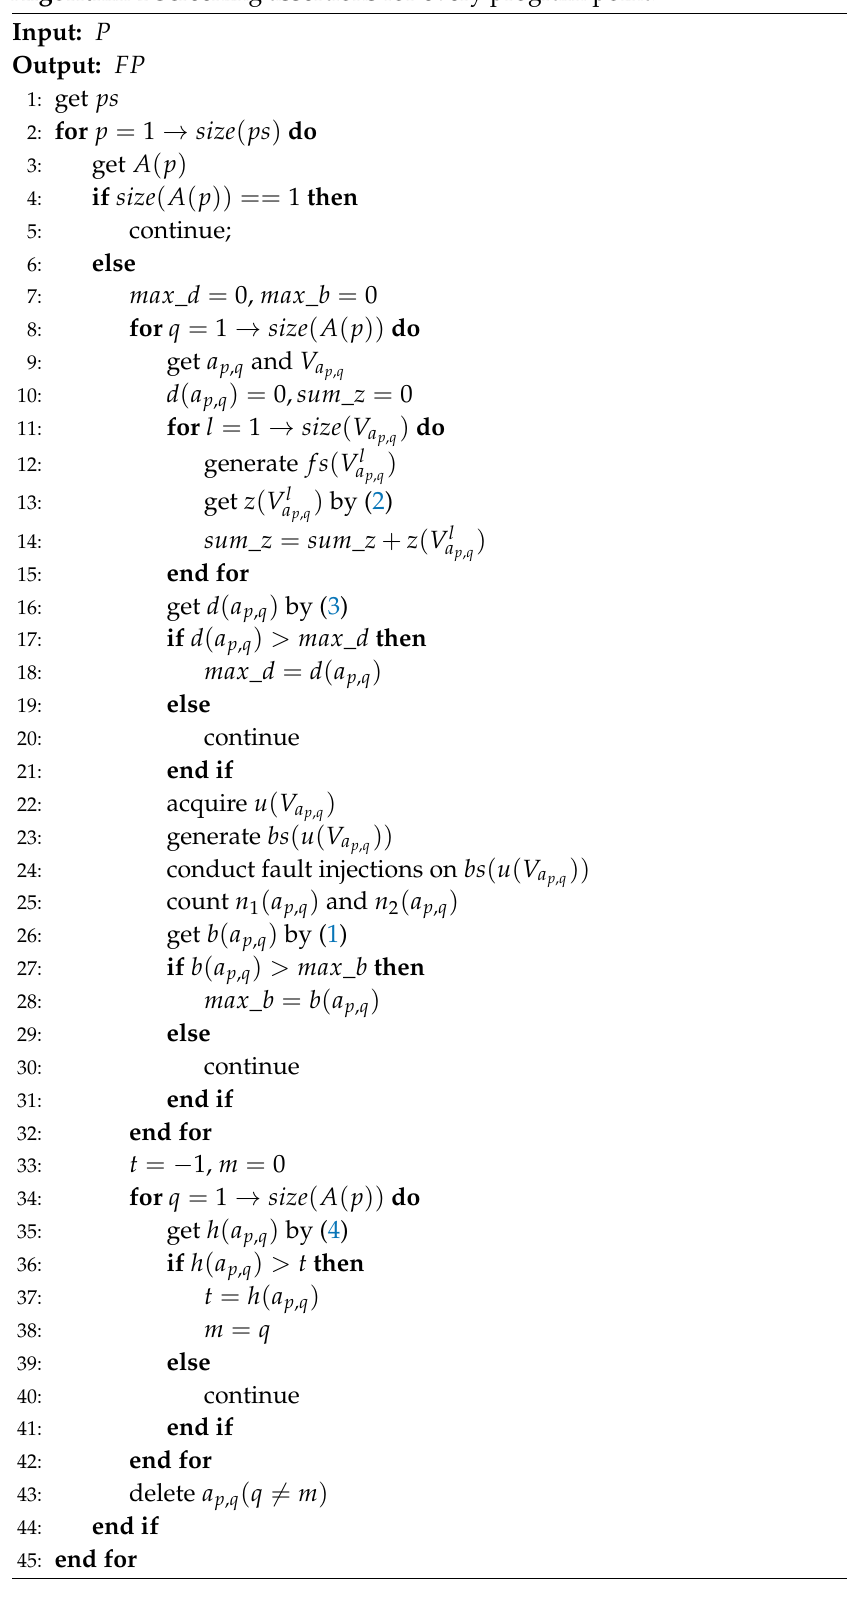
Algorithm 1 Screening assertions for every program